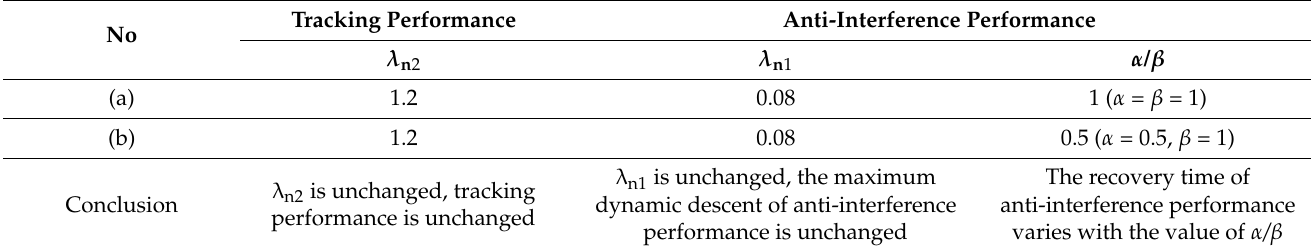
Table 4. Two-step disturbance schemes and corresponding conclusions.